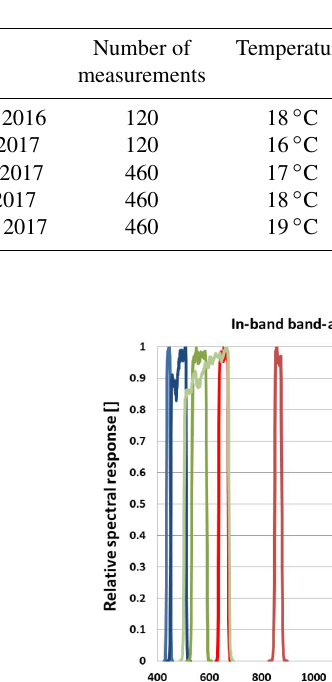
Table 1. Dates of each phenological stage and number of measurements taken in each phenological stage. The temperature and relative humidity recorded are also shown.